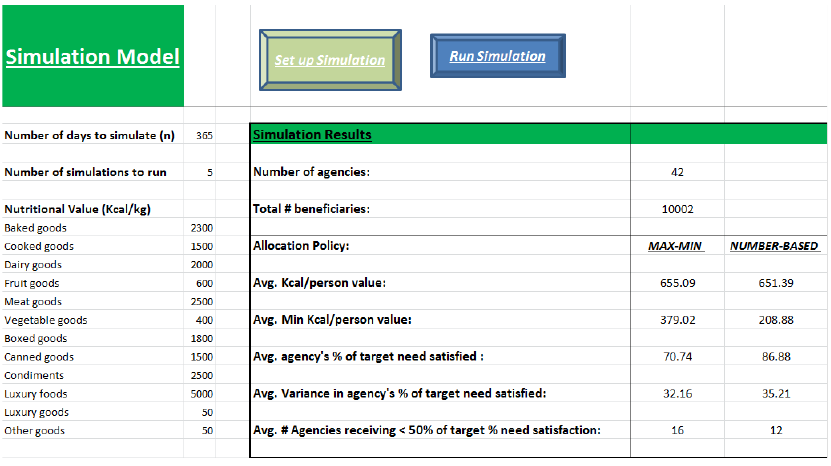
Figure 5: A screenshot of the simulation